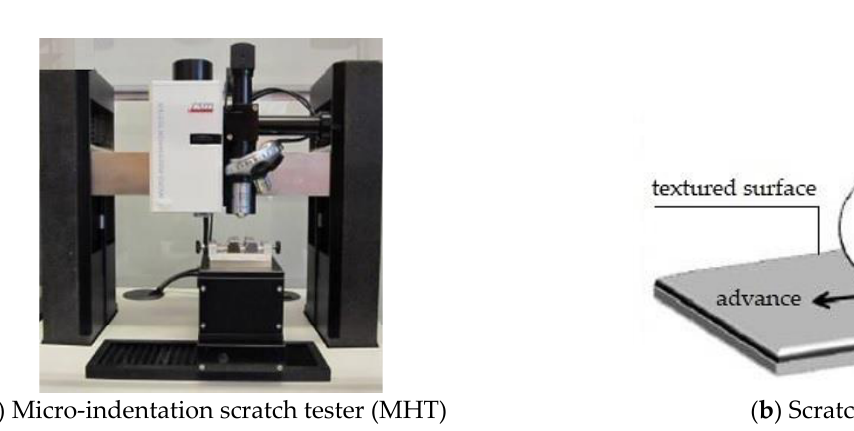
Figure 3. Scratch test configuration.